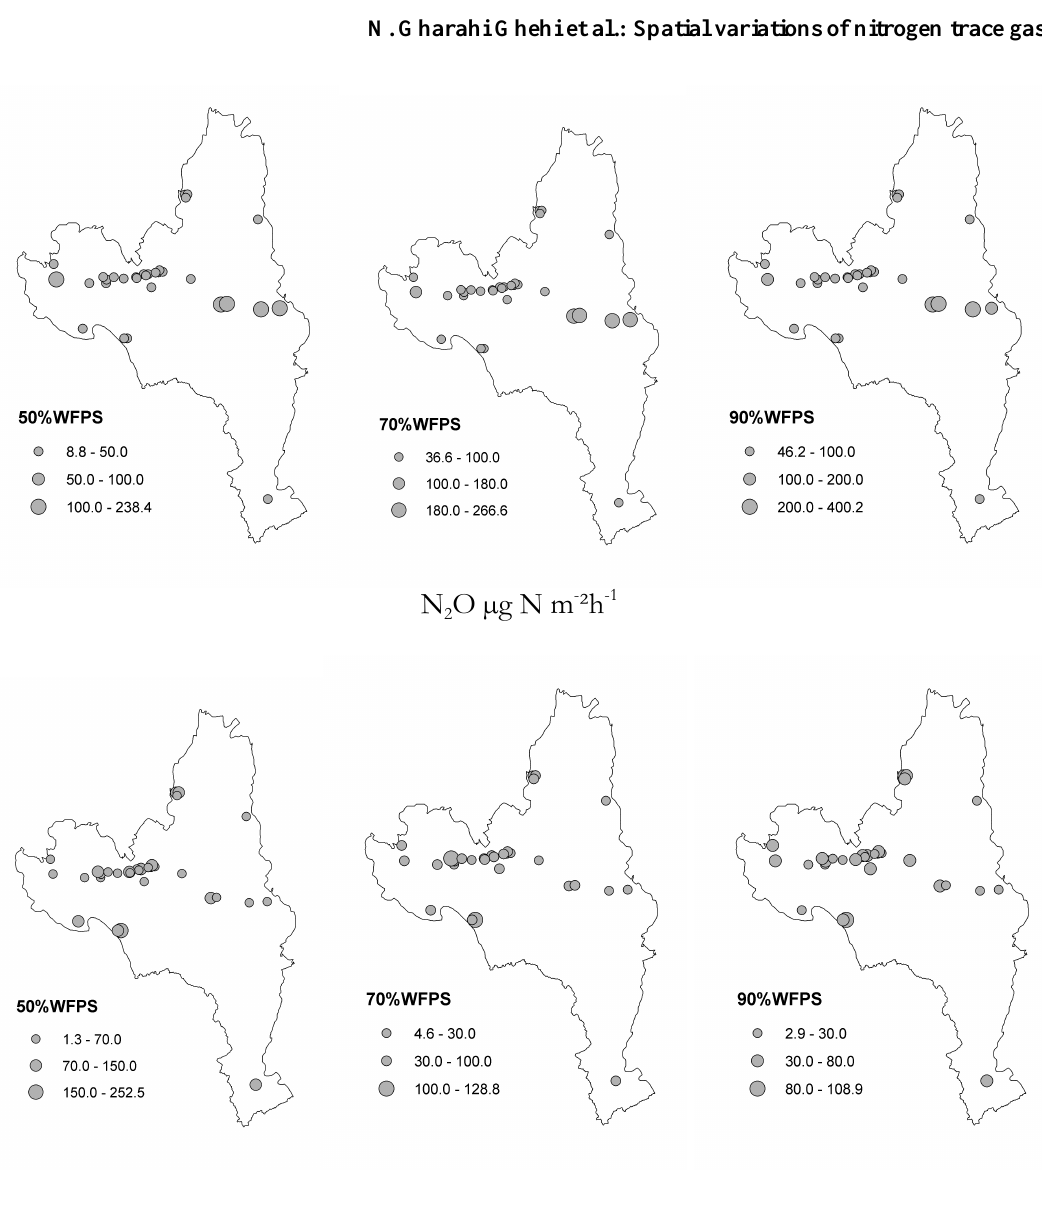
subset 2: locations at low altitude and schists as dominant parent